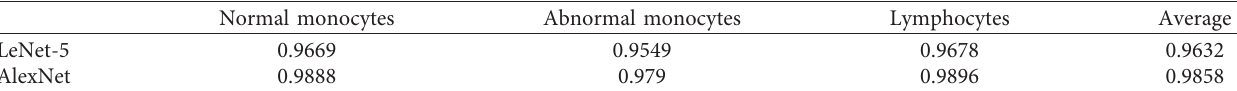
Table 4: Performance comparison of both LeNet-5- and AlexNet-based models in terms of Accuracy in each